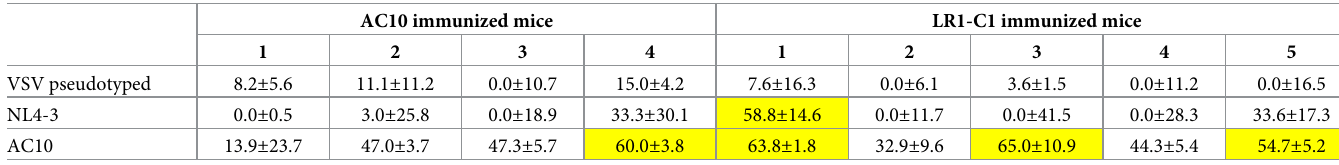
Numbers indicate percent neutralization ± standard deviation. A white box indicates < 50% neutralization and a yellow box indicates > 50% neutralization.